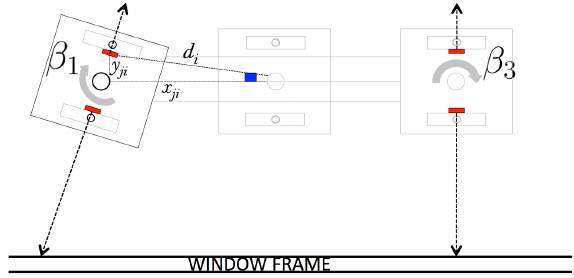
Figure 7. Rotation of the pad β 1 in relation to the rest of the modules, β 2 and β 3 ; this modifies the alignment of the pads and, therefore, the measurement point.